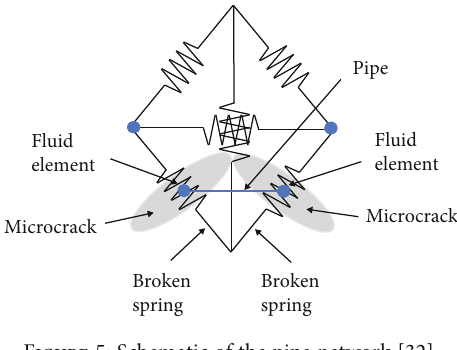
Figure 5: Schematic of the pipe network [32].